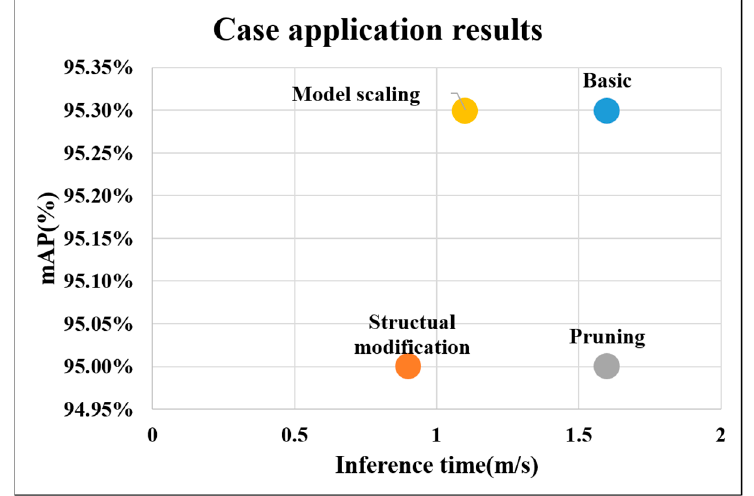
Figure 17. Result analysis graph. Table 5. mAP analysis (model scaling).